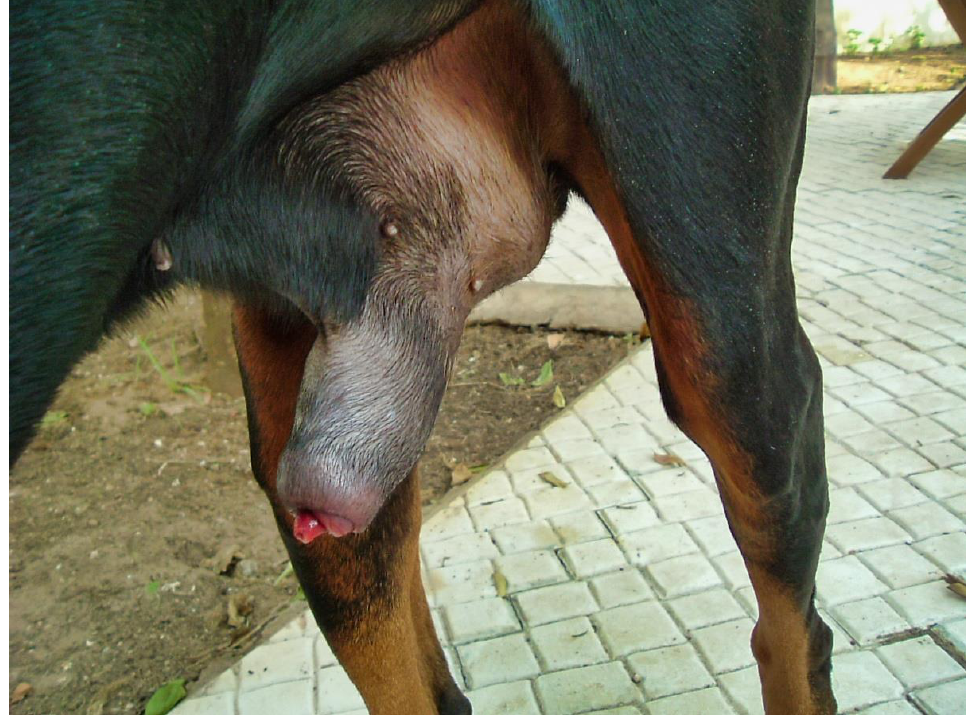
Figure 1. Marked enlargement of the penis, which protrudes slightly from the prepuce. Partial exteriorization of the penis revealed a markedly engorged, rigid penis, dark purple in color with a darker area (Figure 2).